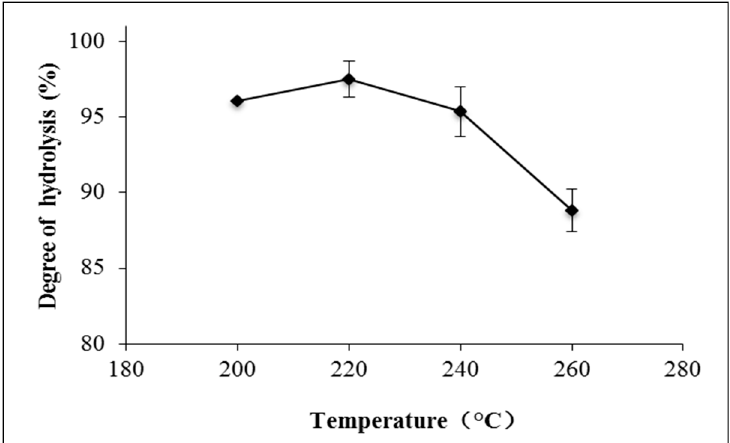
Figure 3. The effect of temperature on the hydrolysis of Schizochytrium sp. oil. Conditions: Water to oil ratio 10:1 (w:w), reaction time 5 hours, 150 rpm.